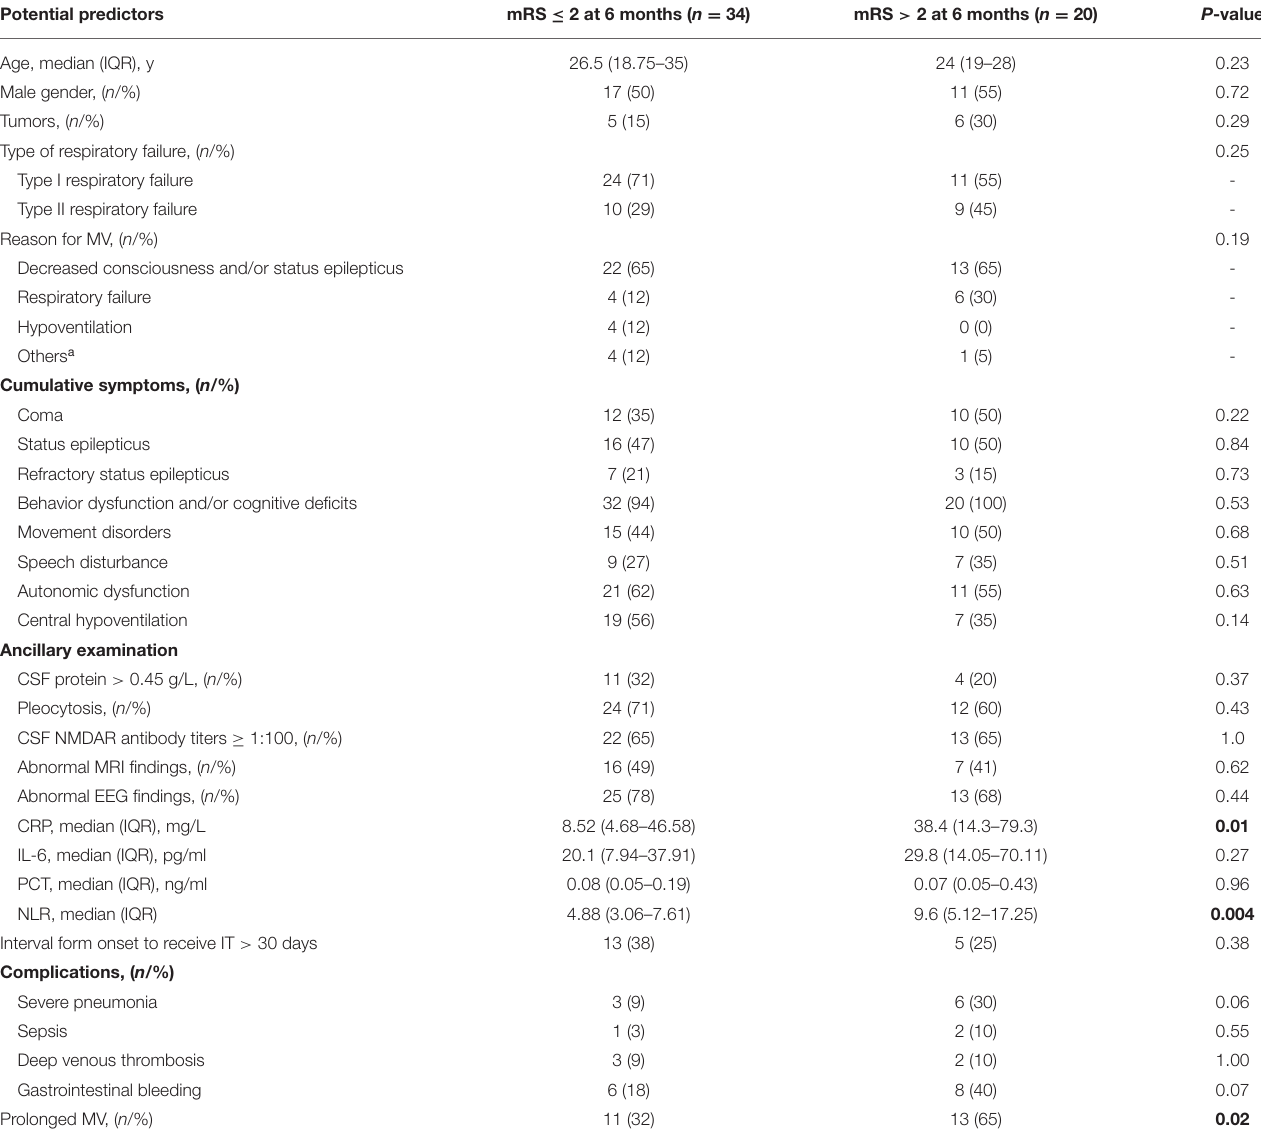
TABLE 4 | Predictors for the poor neurologic outcome (mRS > 2) at the 6-month follow-up. Potential